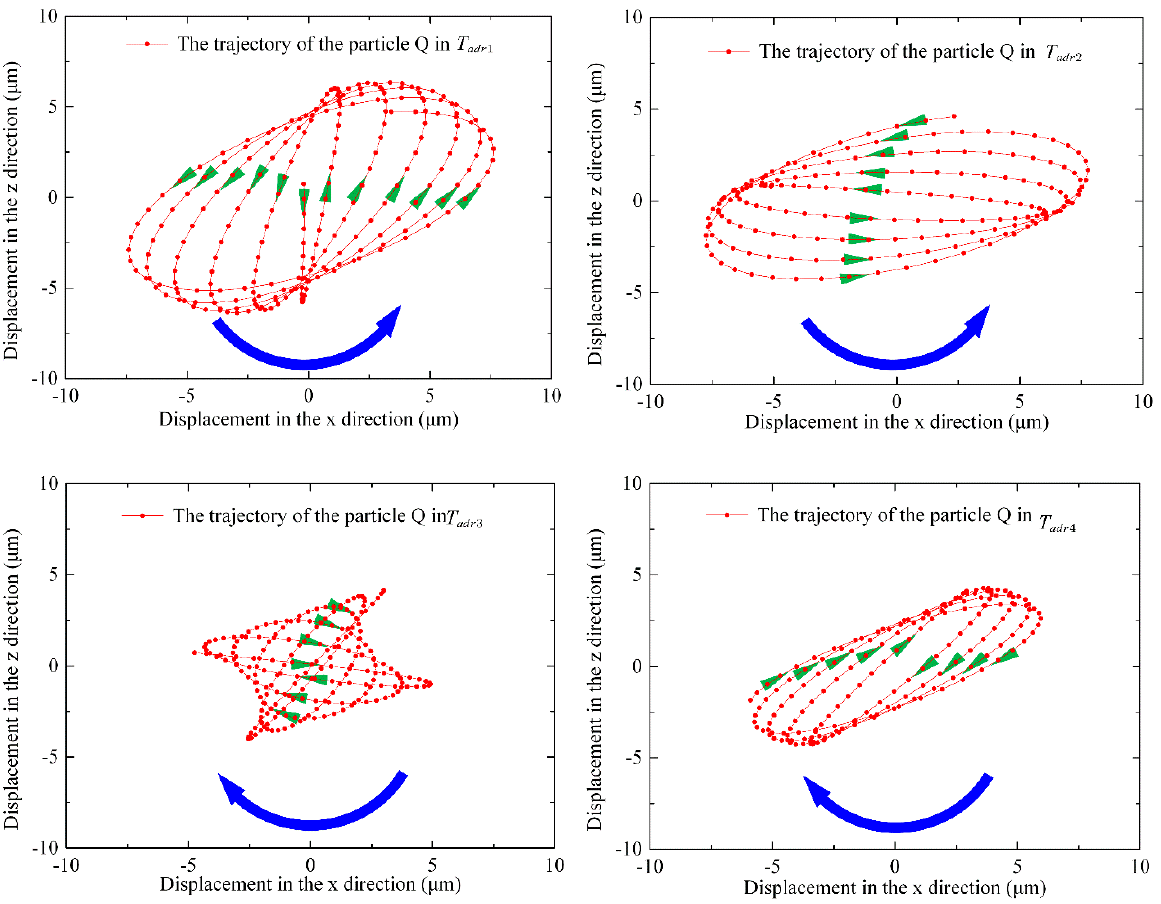
Figure 12. Elliptical trajectory of particle Q.